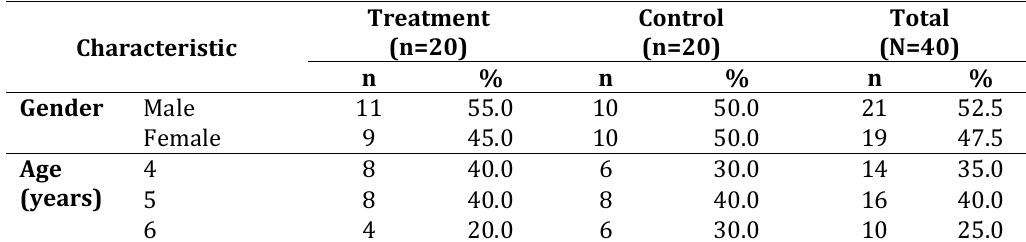
Distribution of frequency of characteristics of children based on gender, and age in Srikandi Room Jombang Hospital in 2021